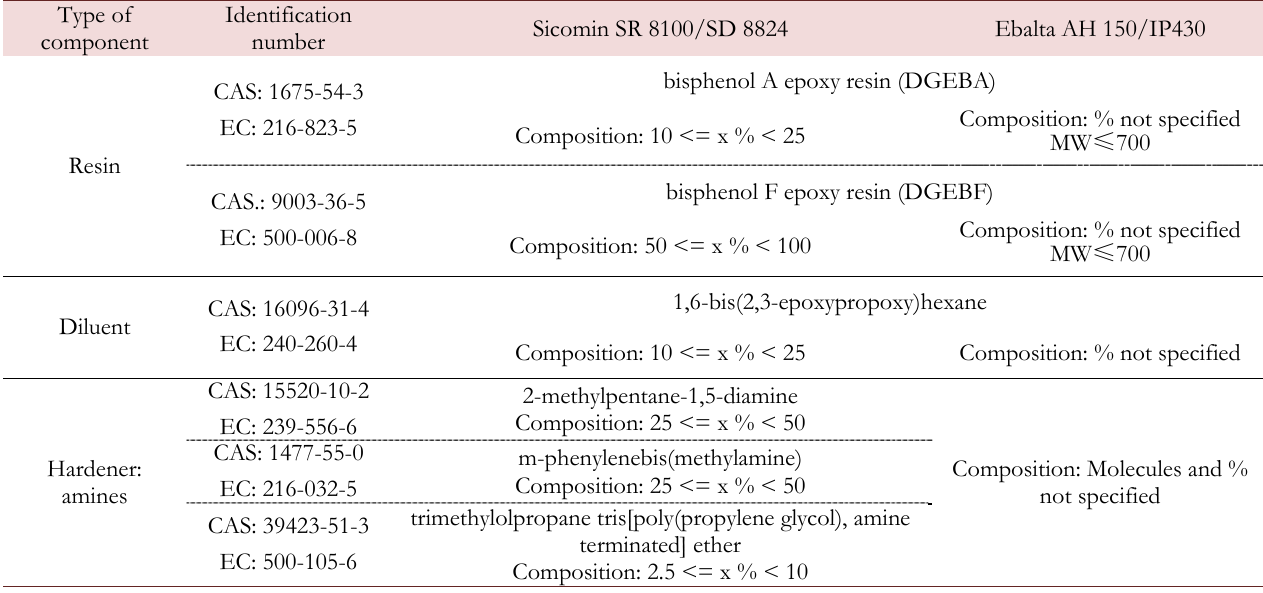
Table 2: Chemical composition of the epoxy resins, diluent and hardeners used in this study based on the data known from their technical